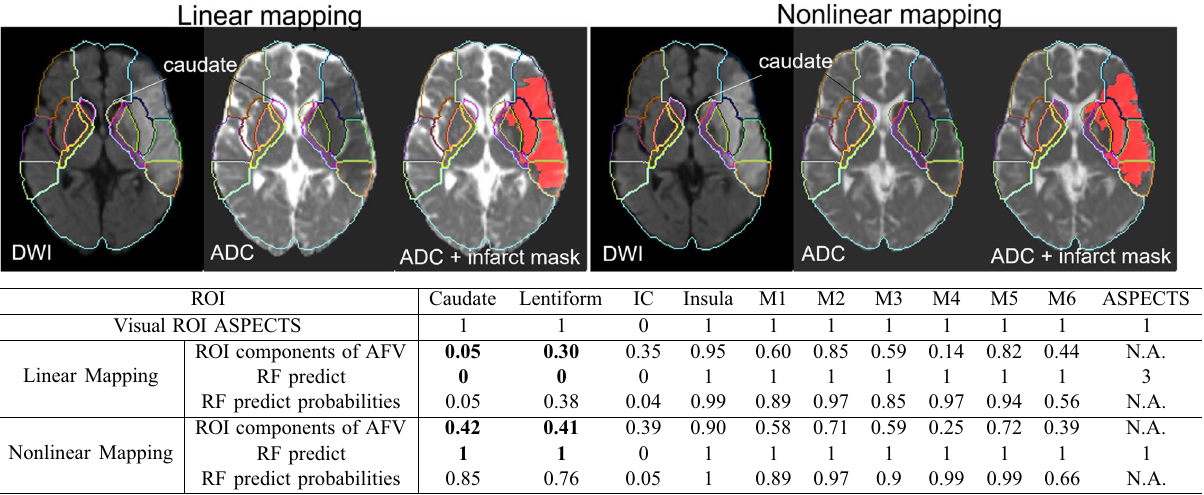
Figure 4. Illustrative example of prediction error related to brain mapping. Note that when the brain is mapped to the template by linear transformation, the agreement of internal structures with their atlas definition is sub-optimum. This is particularly important for brains with specific characteristics (e.g., hydrocephalus) and periventricular structures (e.g., caudate). The imprecision affects the calculus of the proportion of the region affected by the stroke and consequently, the prediction of ASPECTS. In this case, the linear brain mapping to the template (left panel) grades the caudate as 5% affected by the infarct and it consequently scores "0" (bold cells in the table). With non-linear mapping (right panel), the match between the brain and atlas increases; the caudate injury is now quantified as 42% and the predicted score is 1 (bold cells in the table), in agreement with the human evaluation. The same happened to